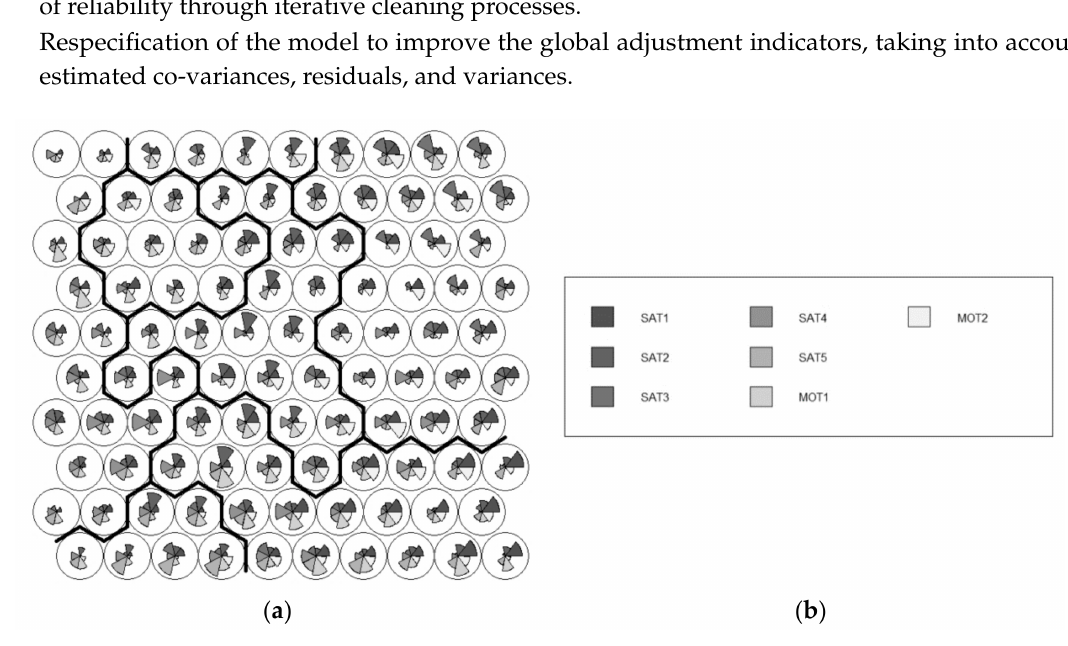
Figure 2. Code Map. Self-organizing map (SOM) results; ( a ) Code map showing the intensity / importance in each of the groups of each of the factors (Sat1, Sat2, Sat4, Sat5, Mot1 and Mot2); ( b ) legend where the color of each of them